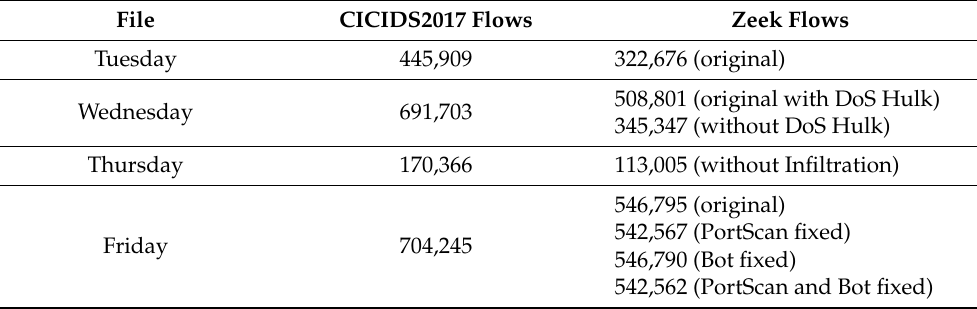
Table 8. Number of flows in the CICIDS2017 dataset and extracted using